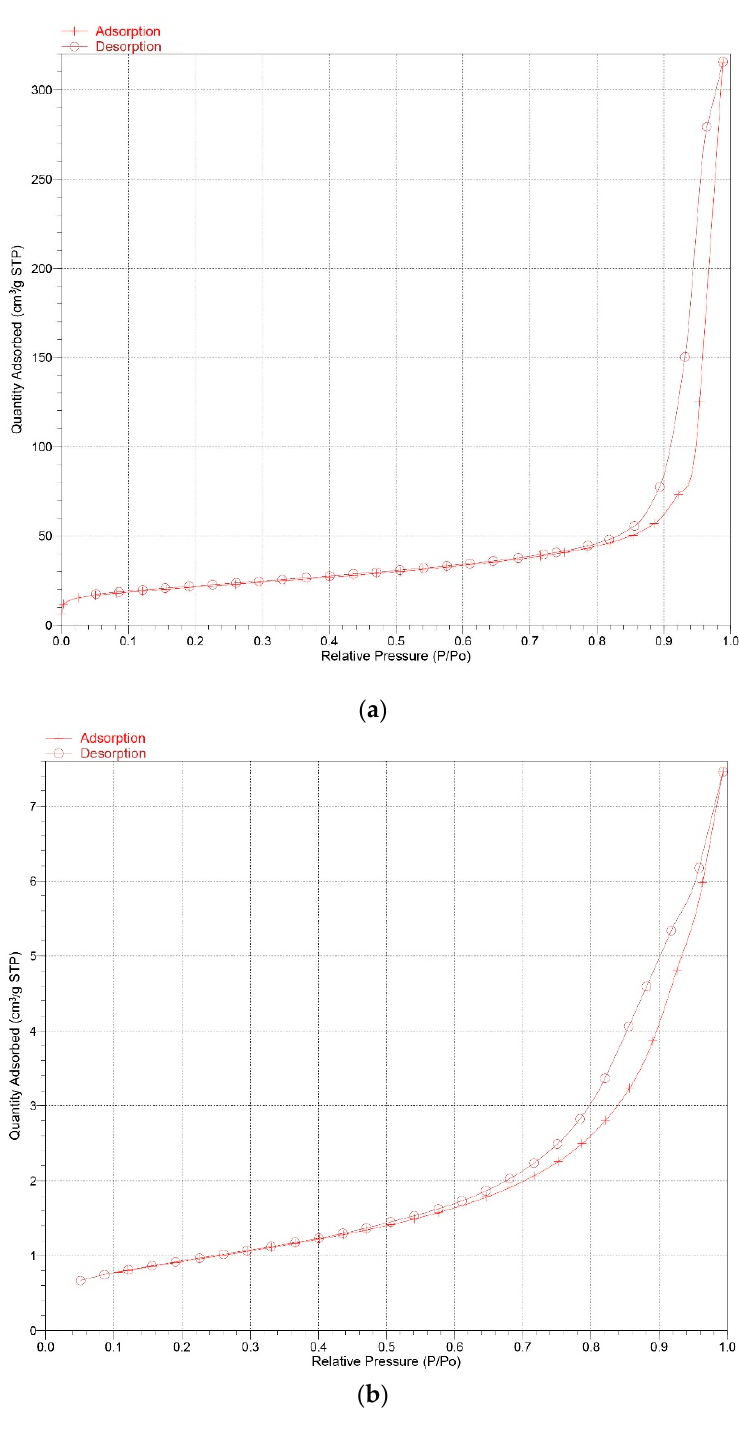
Figure 9. Isothermal adsorption curves of K-A-S-H samples ( a ) K-A-S-H 2.0 2 -7d-60, ( b ) K-A-S-H 2.0 2 -7d-95. Table 2. BET specific surface area of K-A-S-H samples (m 2 /g).